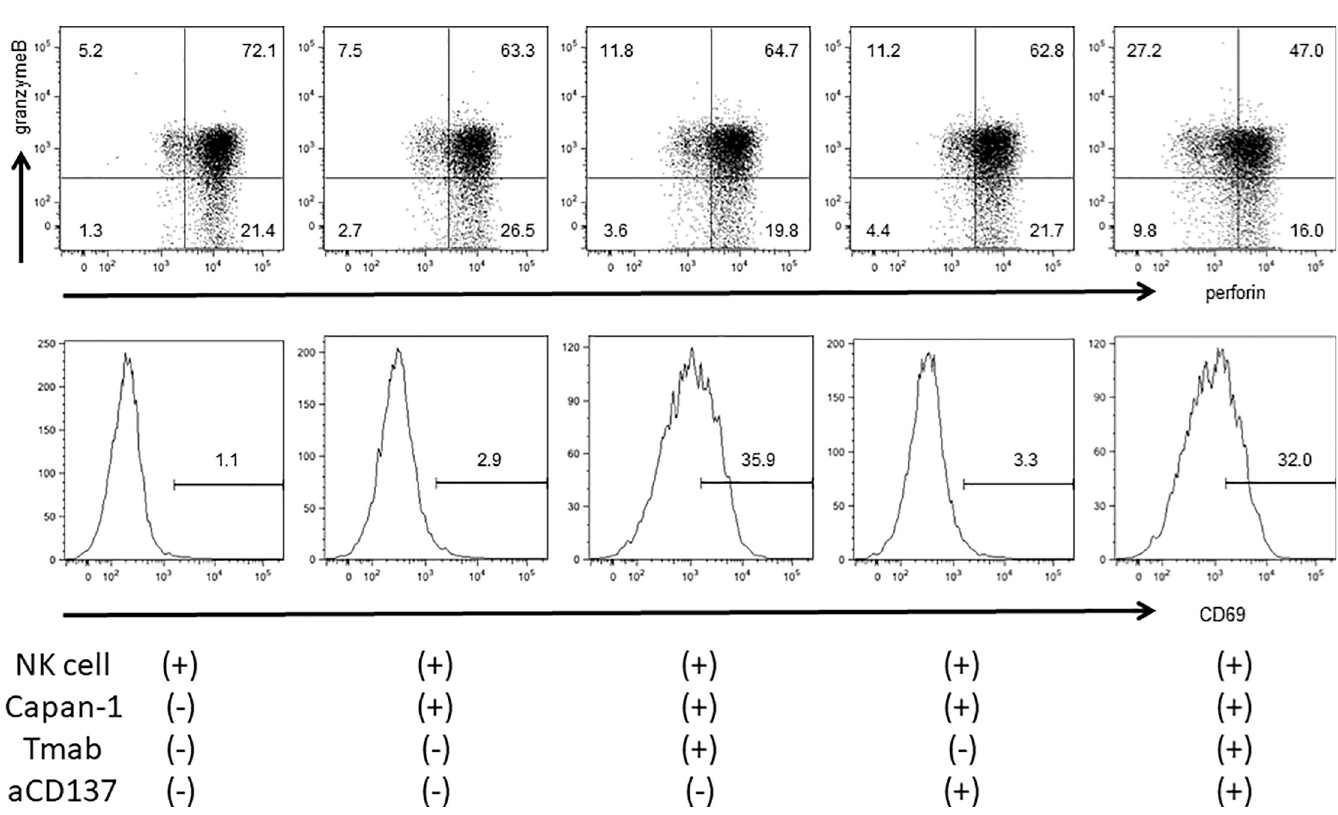
Fig 7. To determine the contribution of Tmab and α CD137 mAb for degranulation from NK cells, changes of intracellular perforin and granzyme-B were analyzed when NK cells obtained from Fc γ RIIIA-VV carrying healthy individuals were incubated with HER2-high-expressing human pancreatic cancer cell line, Capan-1 in the presence of Tmab and/or aCD137 mAb. The upper 5 panels show the percentage of perforin and granzyme-B positive cells in each culture conditions. The activation of NK cells in each condition was simultaneously evaluated by the expression of CD69 on the surface of NK cells and shown in lower 5 histograms. The results shown in this figure were obtained from the representative